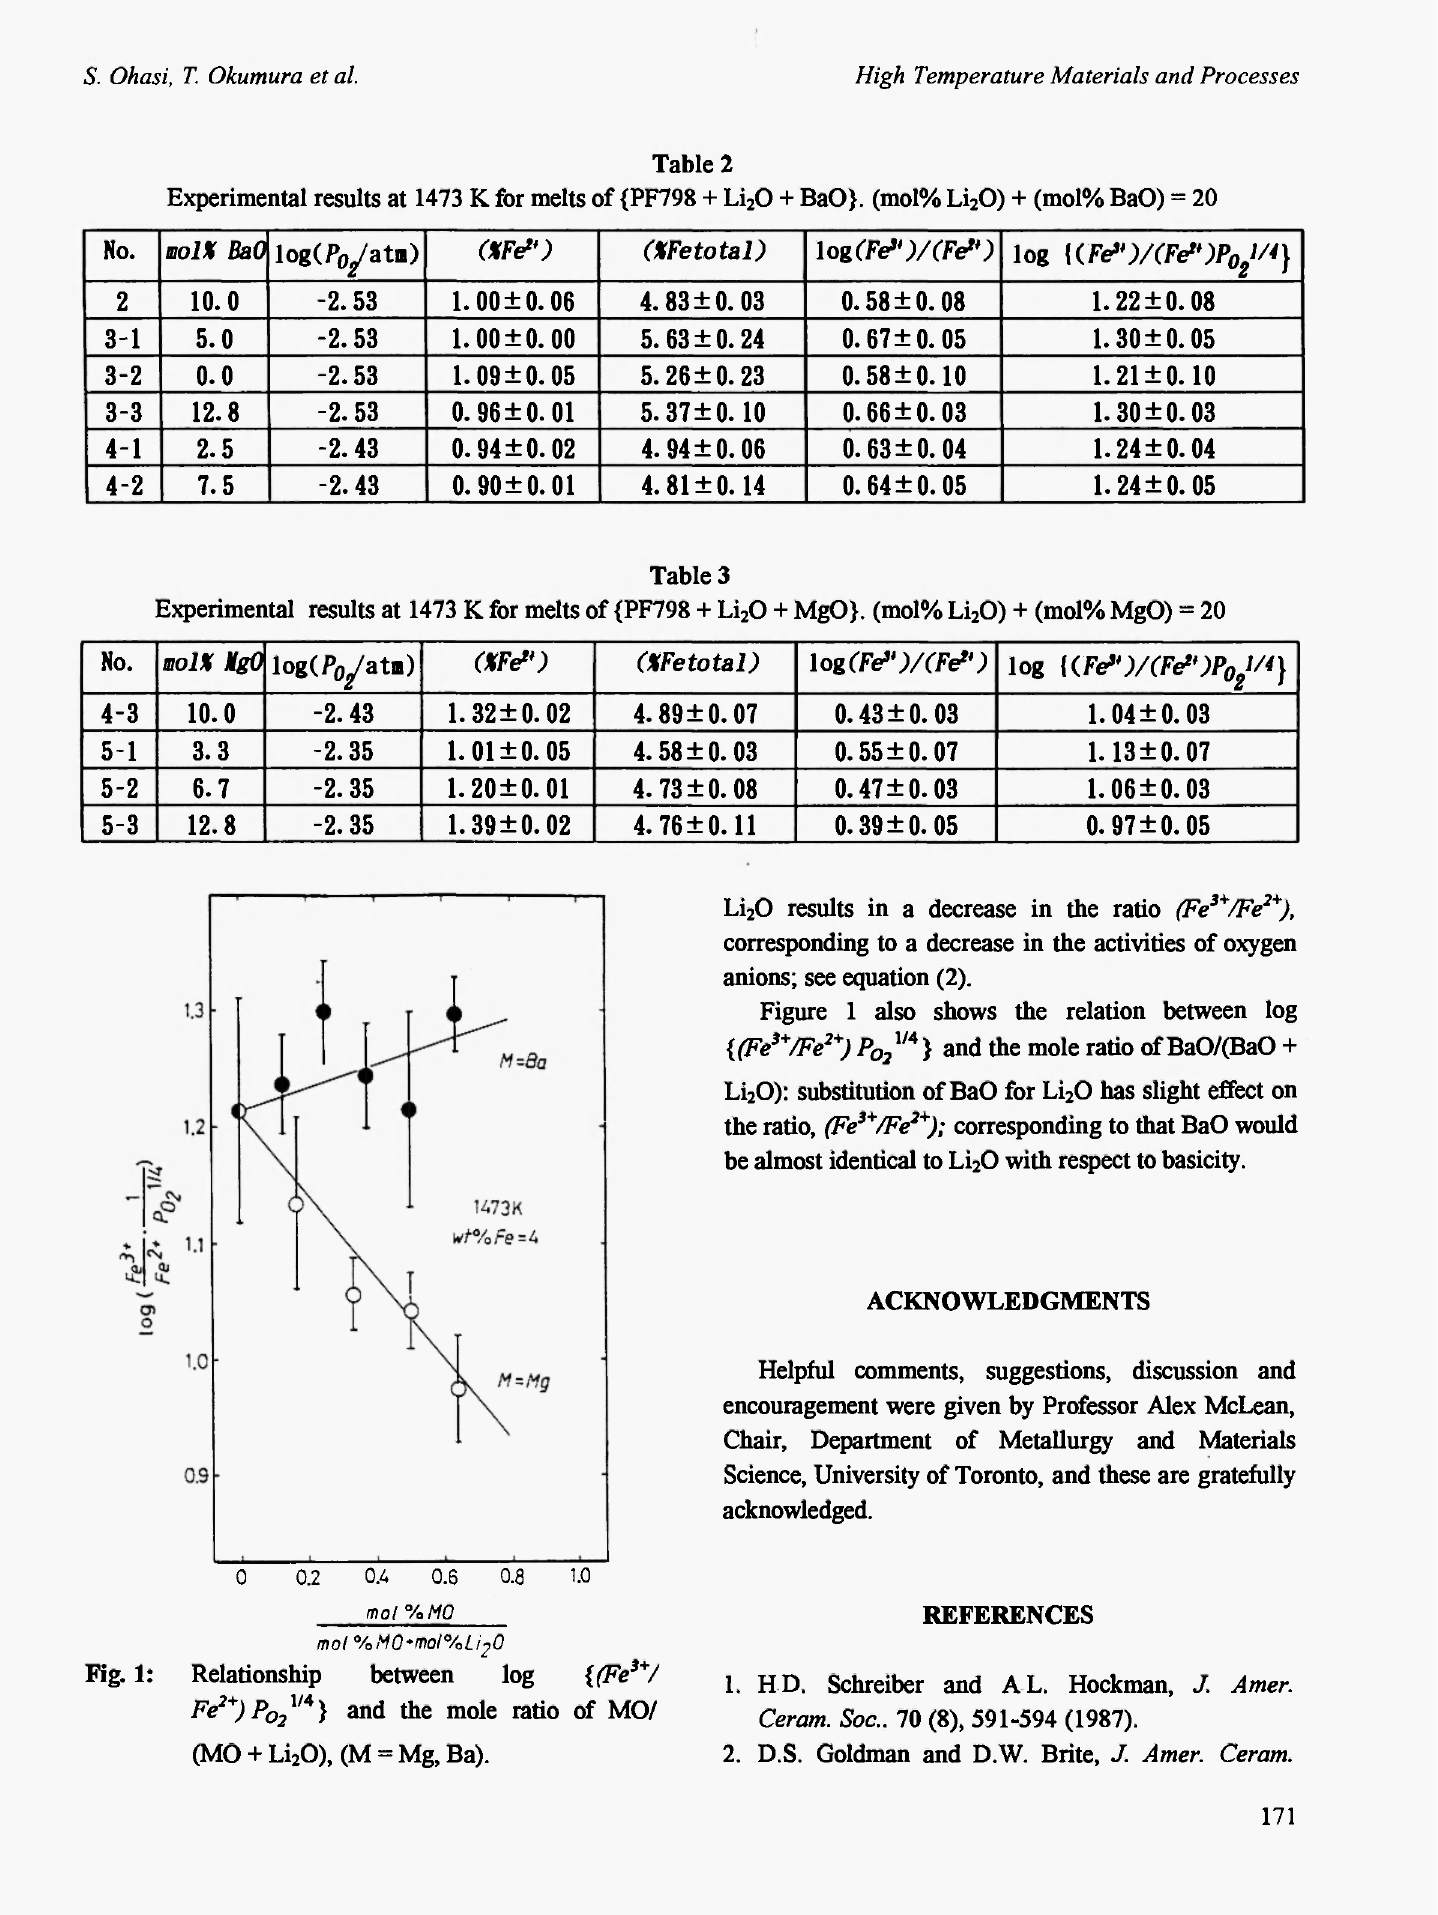
Experimental results at 1473 Κ for melts of {PF798 + Li